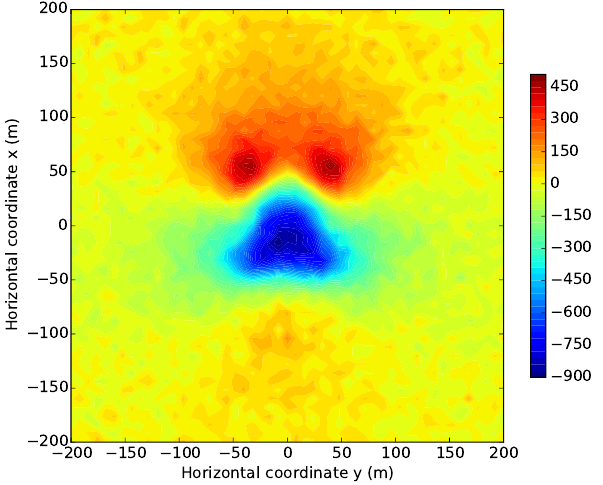
Figure 11. Igneous intrusion. Noise-corrupted total-field anomaly produced by the synthetic bodies shown schematically in Fig. 10. The data are in nT. Table 3. Test with synthetic data (Fig. 9) showing strongly interfer- ing anomalies. Comparison between the estimated and true values of the magnetization declination D and inclination I . The uncertain- ties σ D and σ I (shown between parentheses) are calculated by using Eqs. (34) and (35). All values are in degrees ( ◦ ). We use a caret ( ∧ ) and a tilde ( ∼ ) to distinguish the quantities computed by using, respectively, the least-squares ˆ h and robust e h estimates. Eastern prism Western